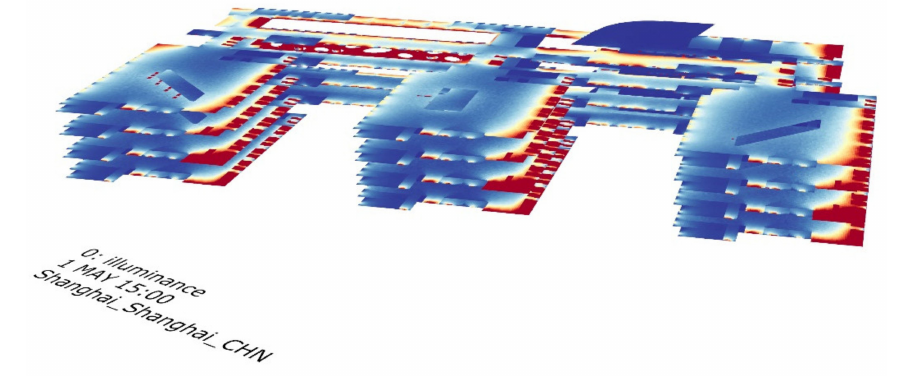
Figure 11. Measuring point layout in the atrium on the fourth floor.